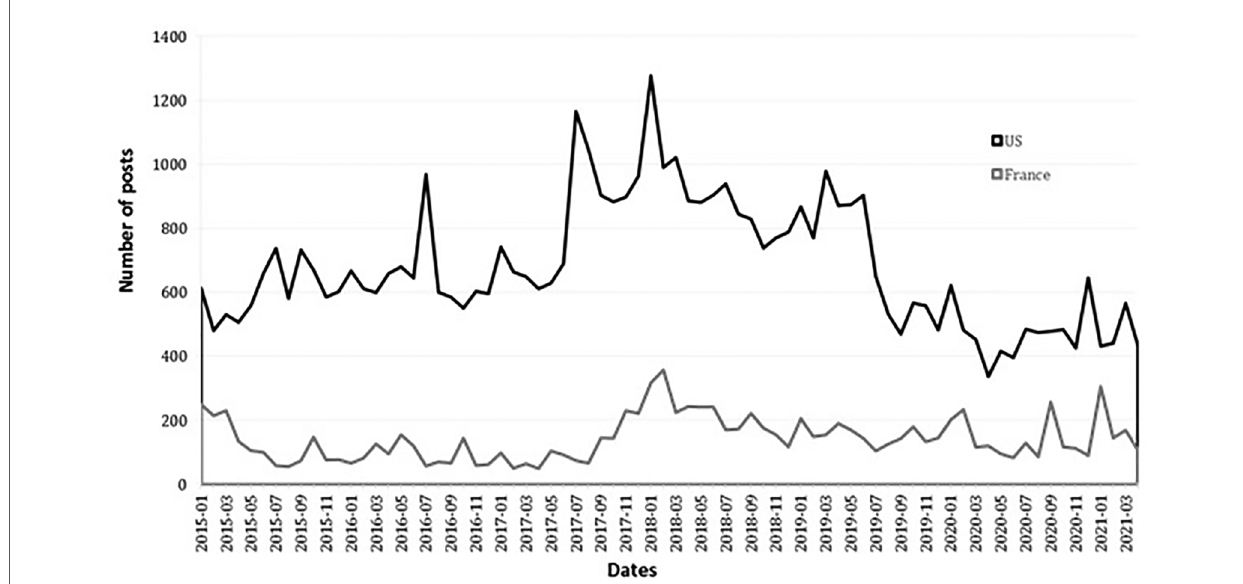
FIGURE 2 Temporal trend of the number of posts on bariatric surgery extracted between January 2015 and March 2021 from social media geolocated in France and the US.